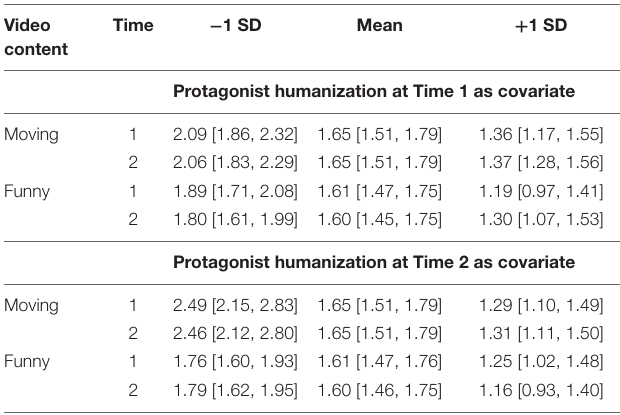
Brackets show 95% confidence intervals. The values indicated correspond to the estimated means of blatant group dehumanization at different levels of protagonist humanization ratings at Time 1 and Time 2: –1 SD, Mean and + 1 SD of their respective